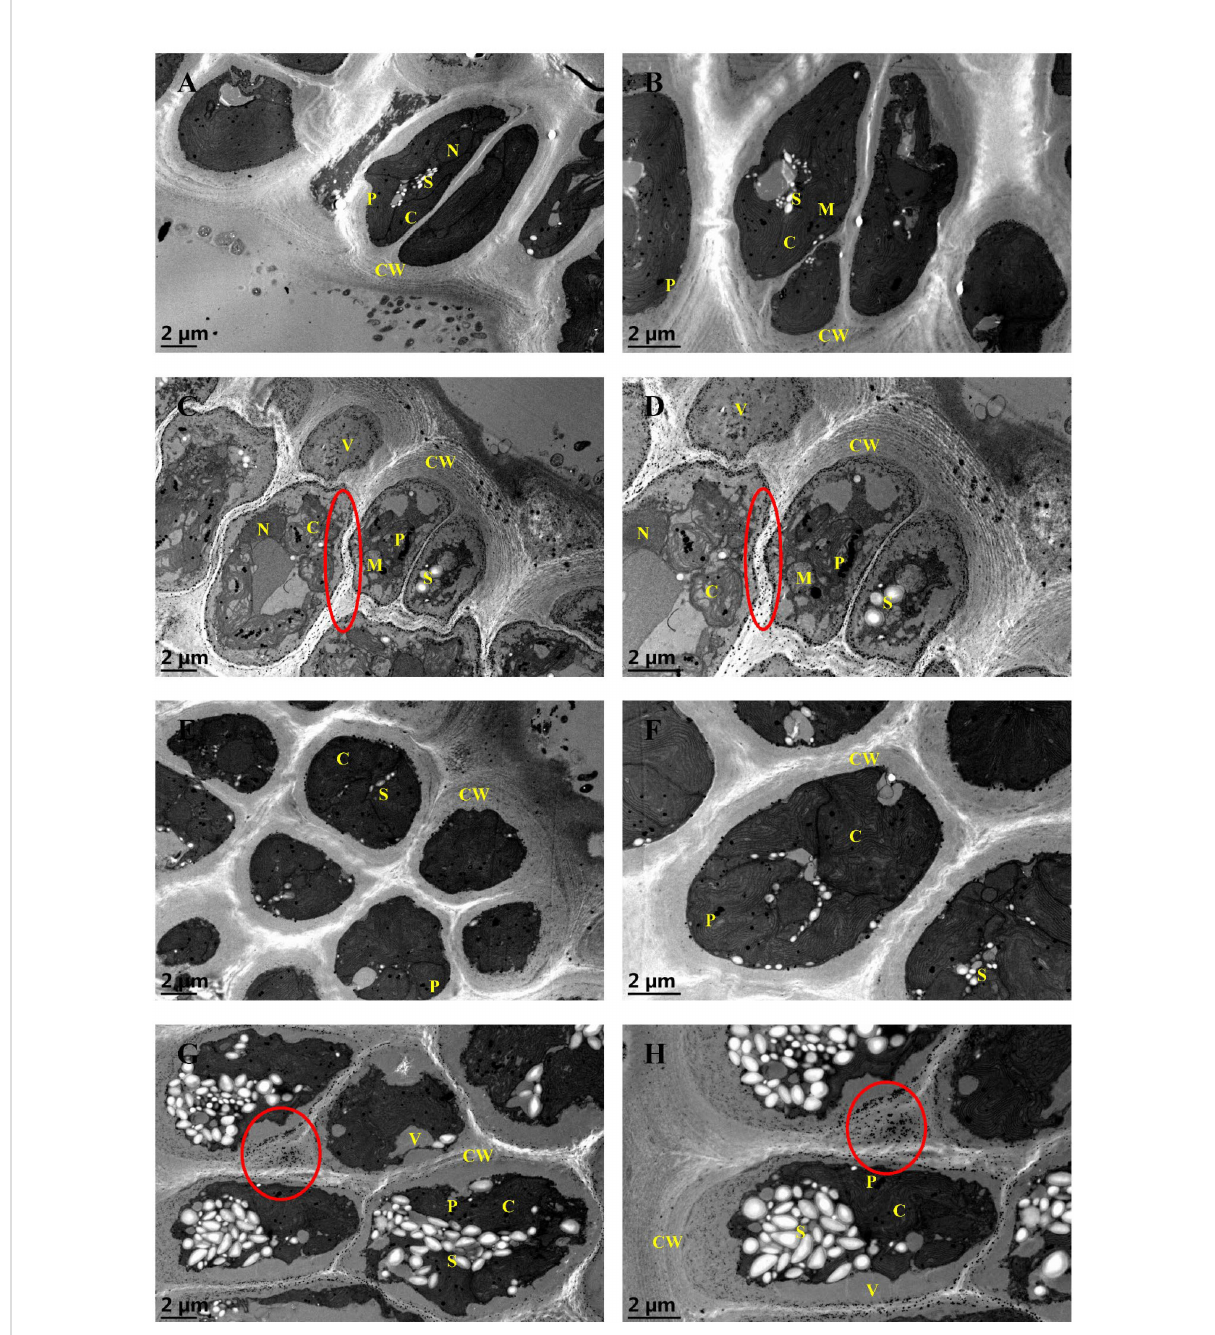
FIGURE 3 TEM ultrastructural images of G bailiniae cortical cells in control and treatment: (A) 8000x control, (B) 12000x control, (C) 8000x Cd treatment, (D) 12000x Cd treatment, (E) 8000x La treatment, (F) 12000x La treatment, (G) 8000x Cd + La treatment, (H) 12000x Cd + La treatment. Circles denote metal deposits; C, chloroplast; CW, cell wall; M, mitochondrion; N, nuclei; P, plastoglobuli; S, starch grain, and V,